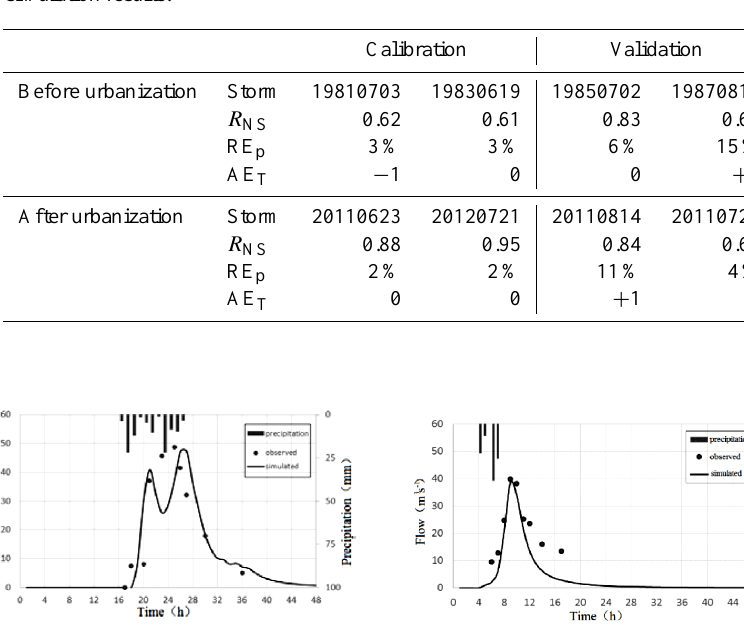
Table 2. Error statistics of simulation results.